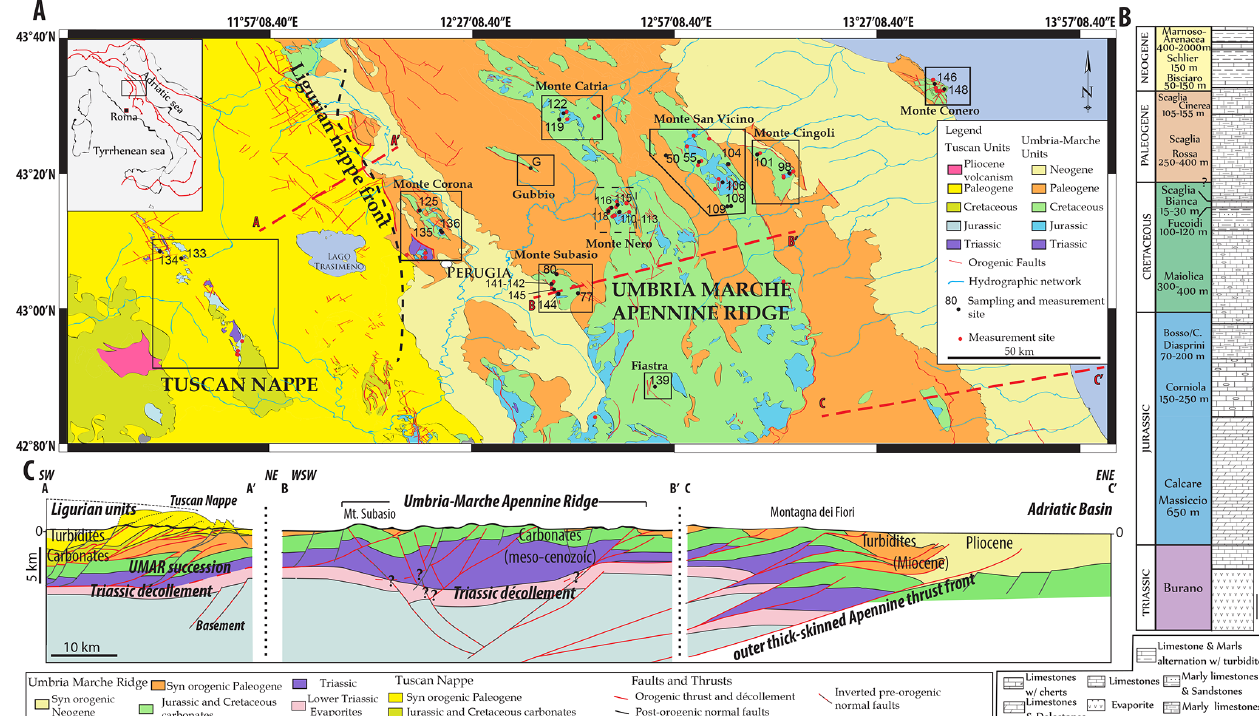
Figure 1. (A) Simplified geological map of the study area, with locations of the sampling and measurement sites. Frames relate to the fracture study areas used in Fig. 4. Exact location of measurement sites is reported as black and red points, and labelled black points also represent the sampling sites for geochemical analysis. (B) Stratigraphic column based on stratigraphic and well data from the central part of the UMAR, after Centamore et al. (1979). (C) Crustal-scale composite cross section based on published seismic data interpretations; A-A’ modified after Carboni et al. (2020); B-B’ and C-C’ after Scisciani et al. (2014). Note that both tectonic style (thick skinned and thin skinned) are represented by question marks for the